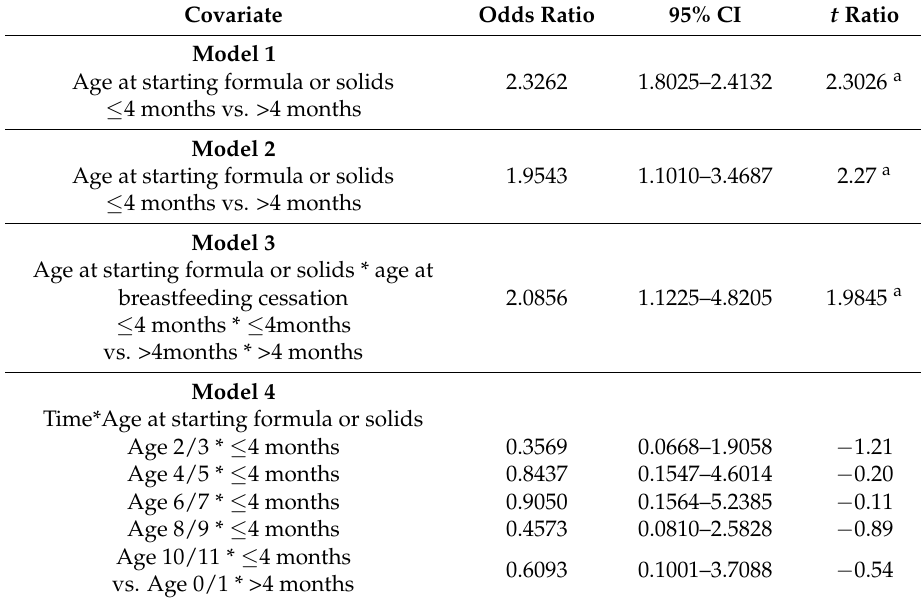
Table 1. Estimated odds ratios, 95% confidence intervals (CI) and t statistic for the effects of age at introduction to formula or solids, the interaction effects between this variable and age at breastfeeding cessation, and timing of follow-up waves on odds of overweight or